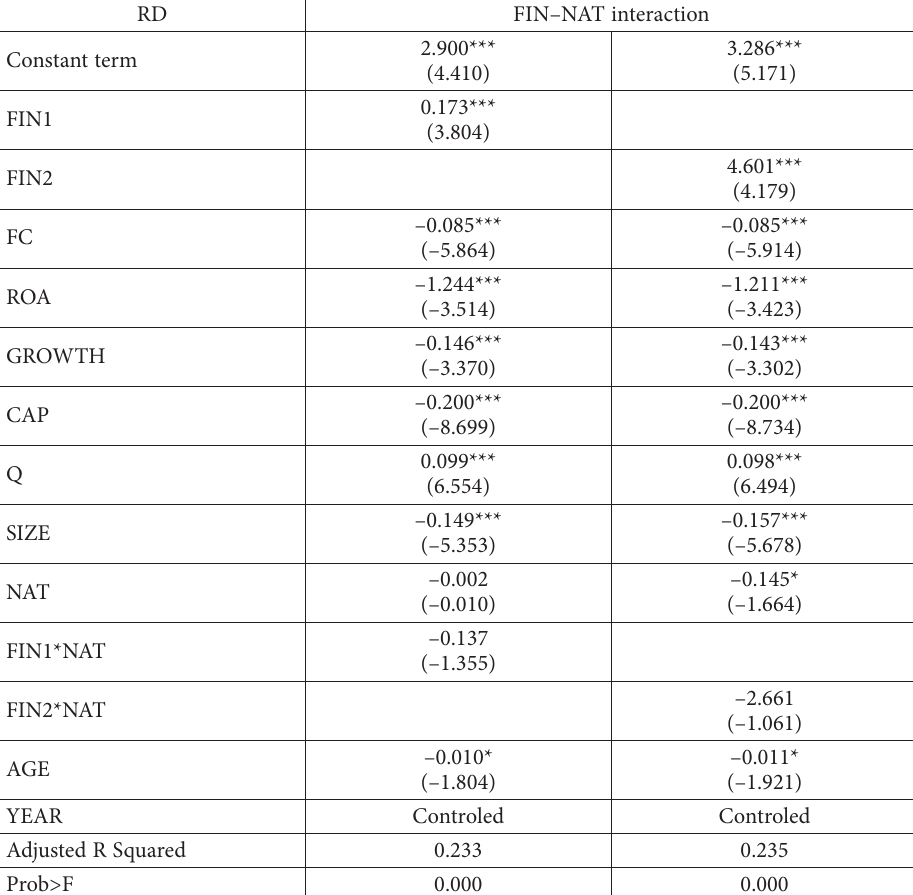
Table 10. Results of Model